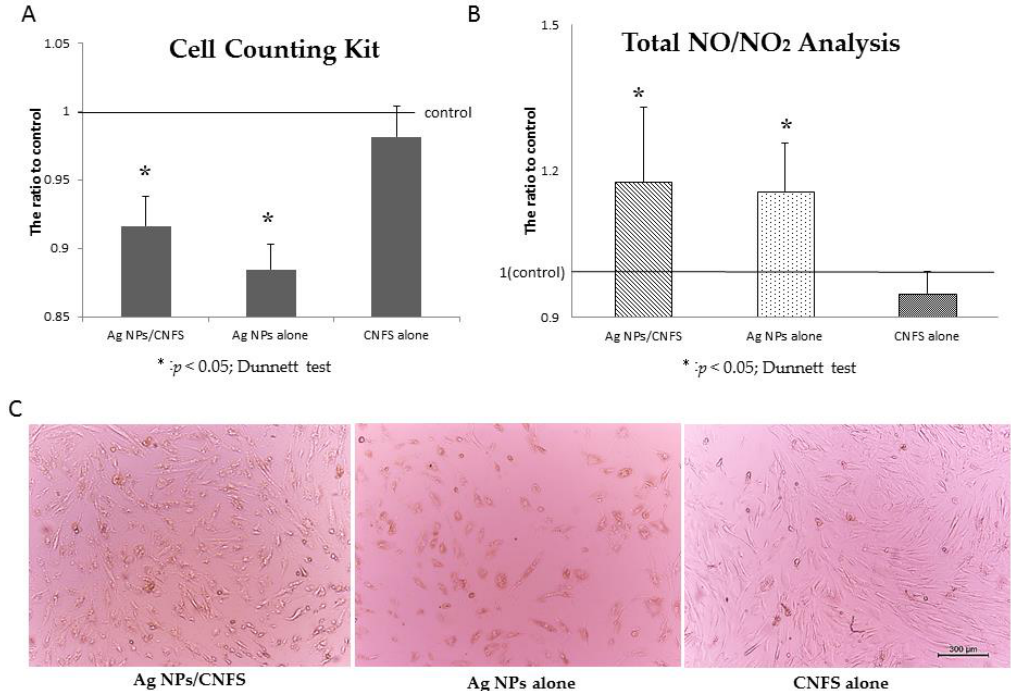
Figure 3. Cytotoxicity of Ag NPs/CNFS in vitro toward fibroblasts. The proliferation of fibroblasts cultured with either Ag NPs/CNFS or Ag NPs as described in Figure 2 decreased for 1-day culture ( A ). Each fibroblast was harvested after cells were exposed to Ag NPs/CNFS for 1 day. The cell lysates were subjected to total NO/NO 2 analysis ( B ). Data represent the mean ± SD of 6 determinations. Microscopic observation showed that the cells in Ag NPs/CNFS- and Ag NPs-groups were necrotized, and each microphotograph was representative of six cultures ( C